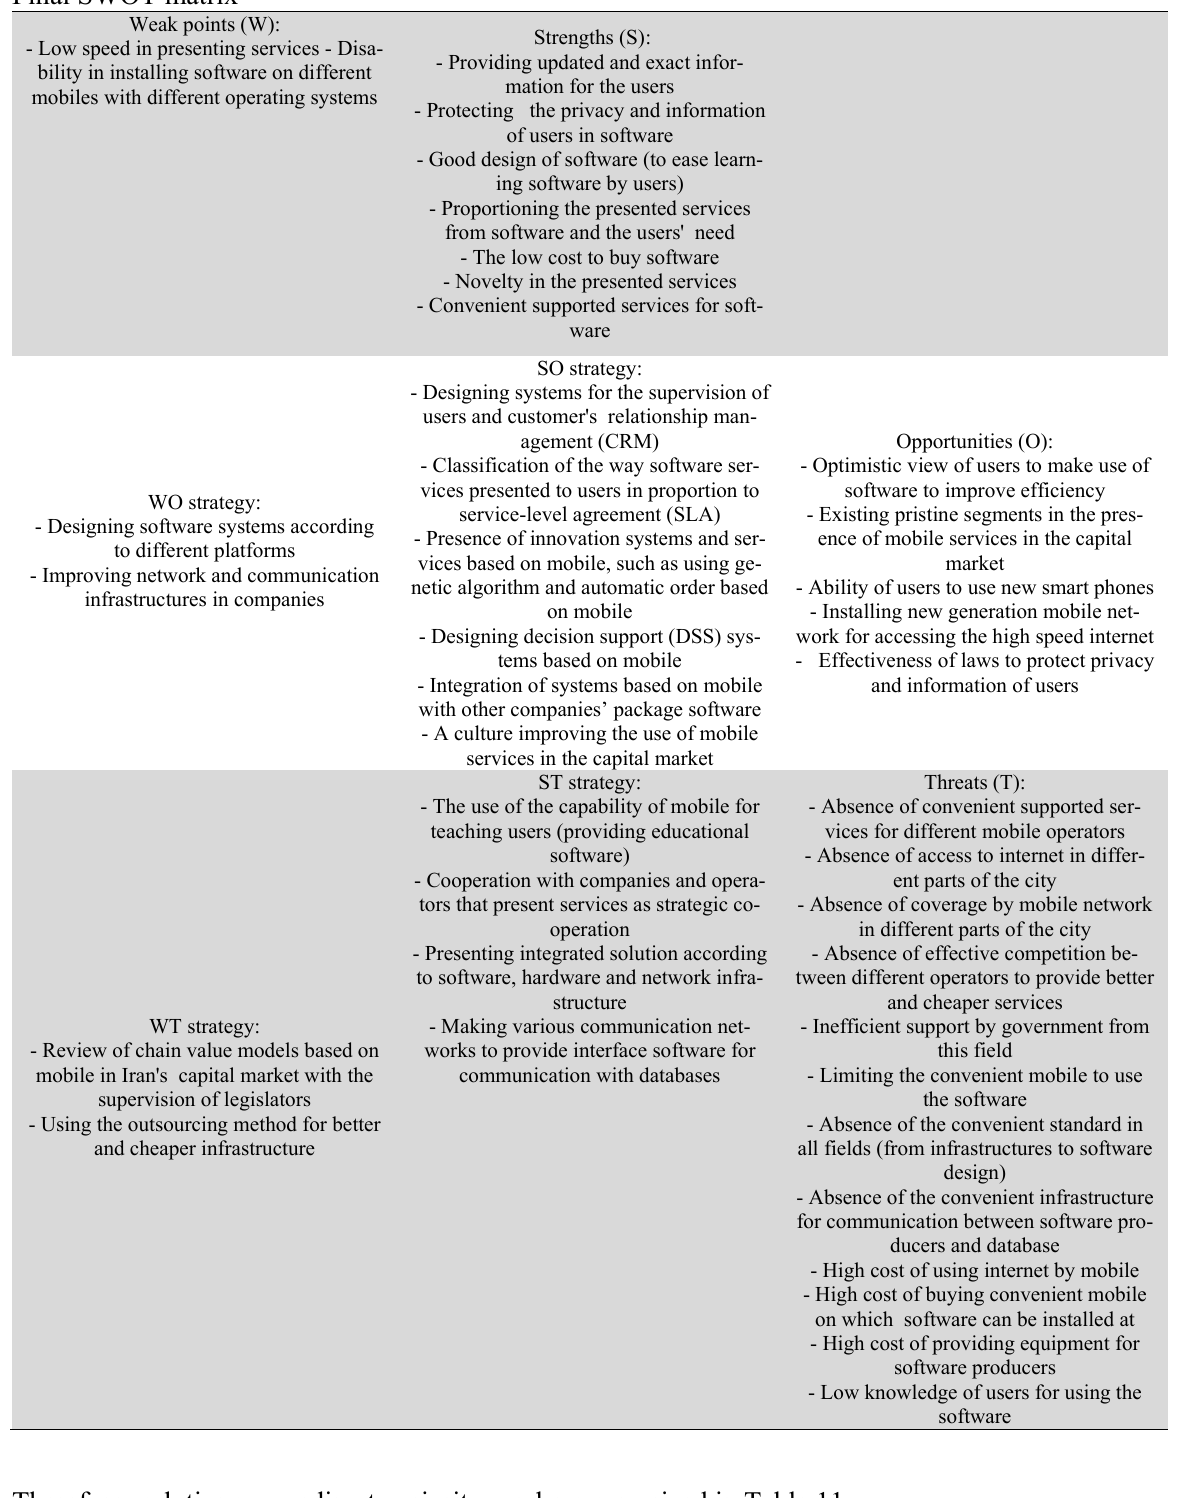
Final SWOT matrix Weak points (W): - Low speed in presenting services - Disa- bility in installing software on different mobiles with different operating systems